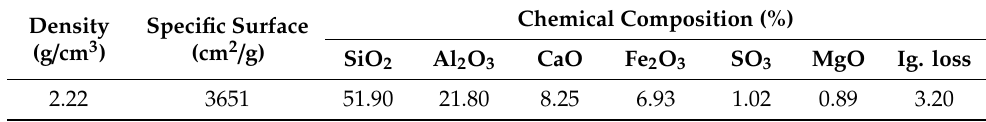
Table 3. Properties of fly ash.